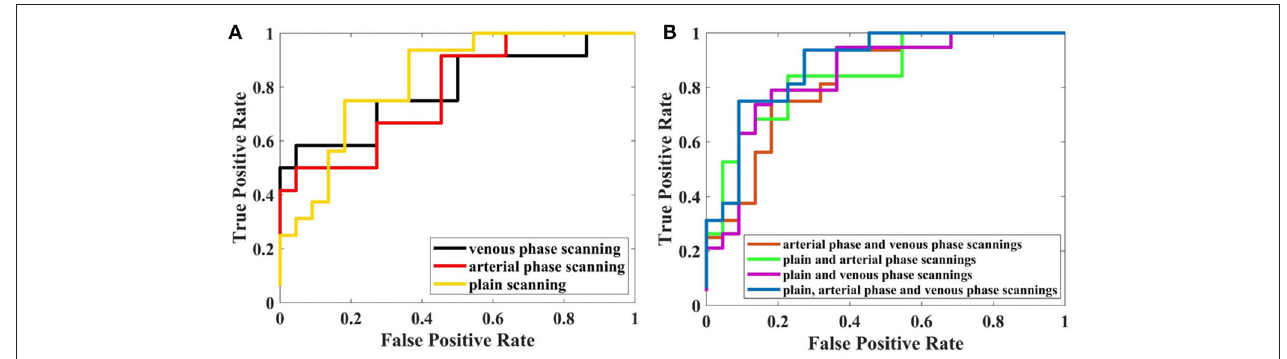
FIGURE 5 | Performance of LR-LASSO model based on different sequences with 5-fold cross-validation. (A) Based on single sequence. (B) Based on multiparametric